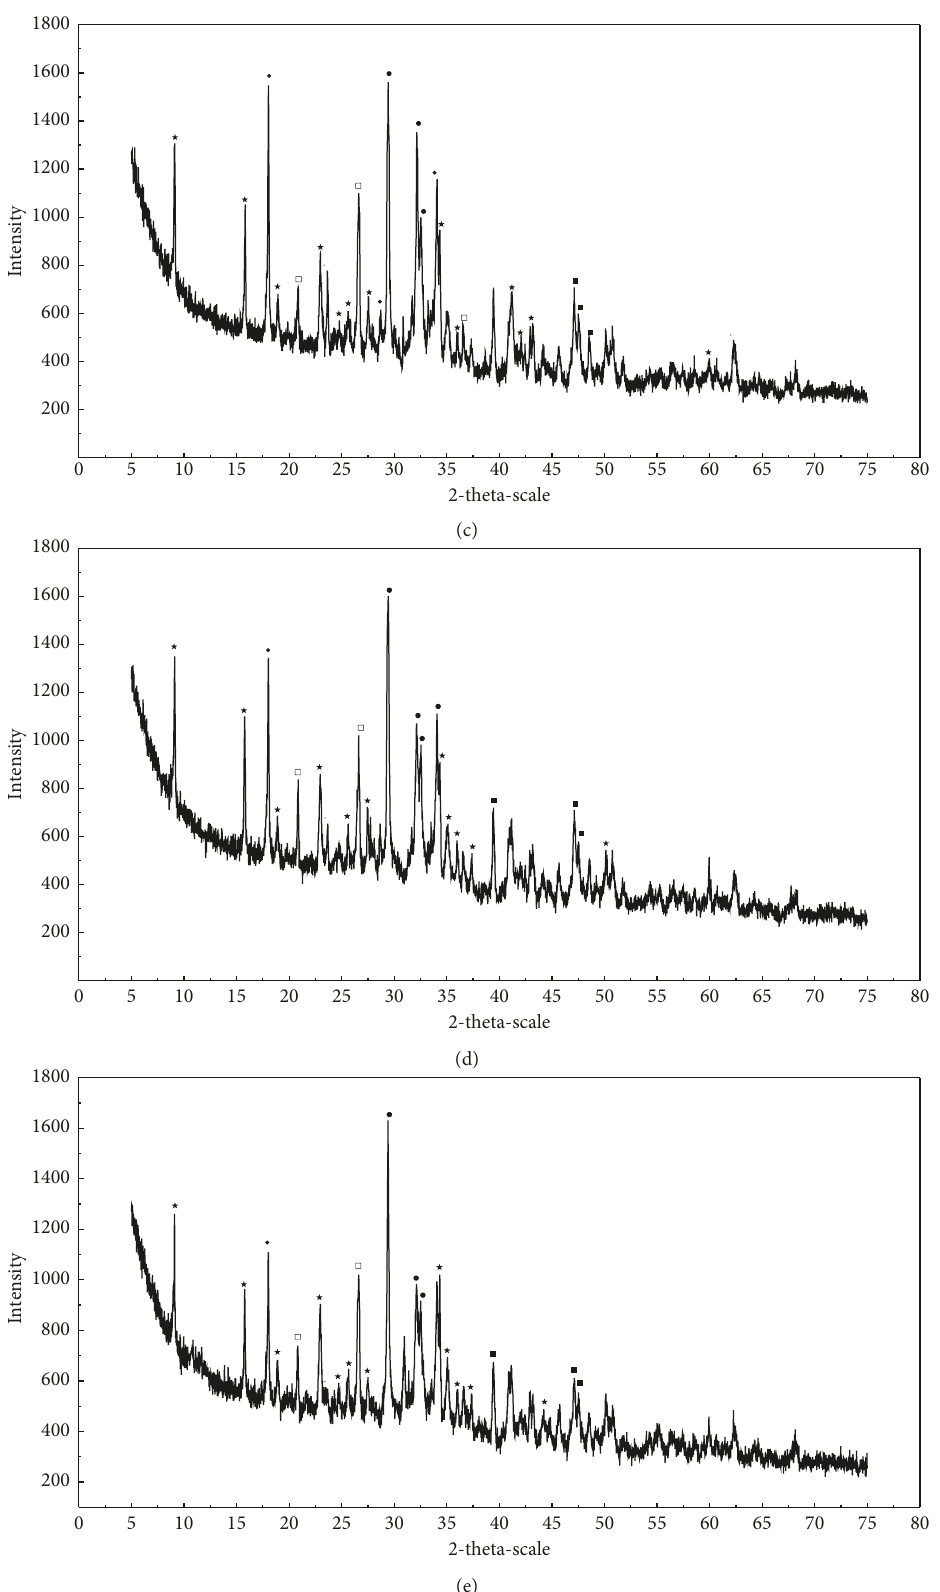
Figure 7: XRD spectra of samples at different hydration ages. ★ -AFt; ⧏ -C-S-H; ◆ -CH; ■ -CaCO (b) 16 h. (c) 1d. (d) 3d. (e)